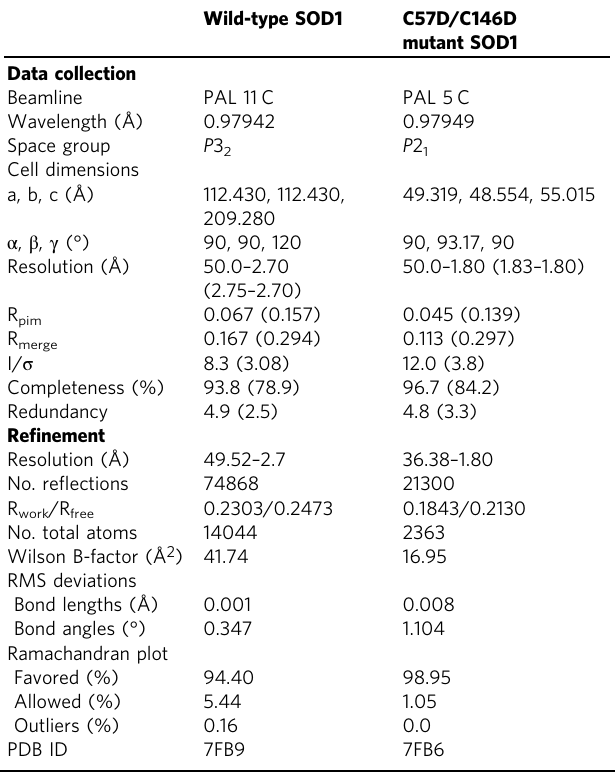
Table 2 Data collection and re fi nement